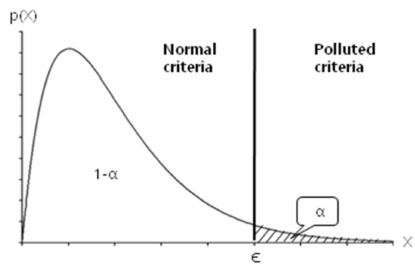
Figure 9. Cumulative distribution function of χ 2